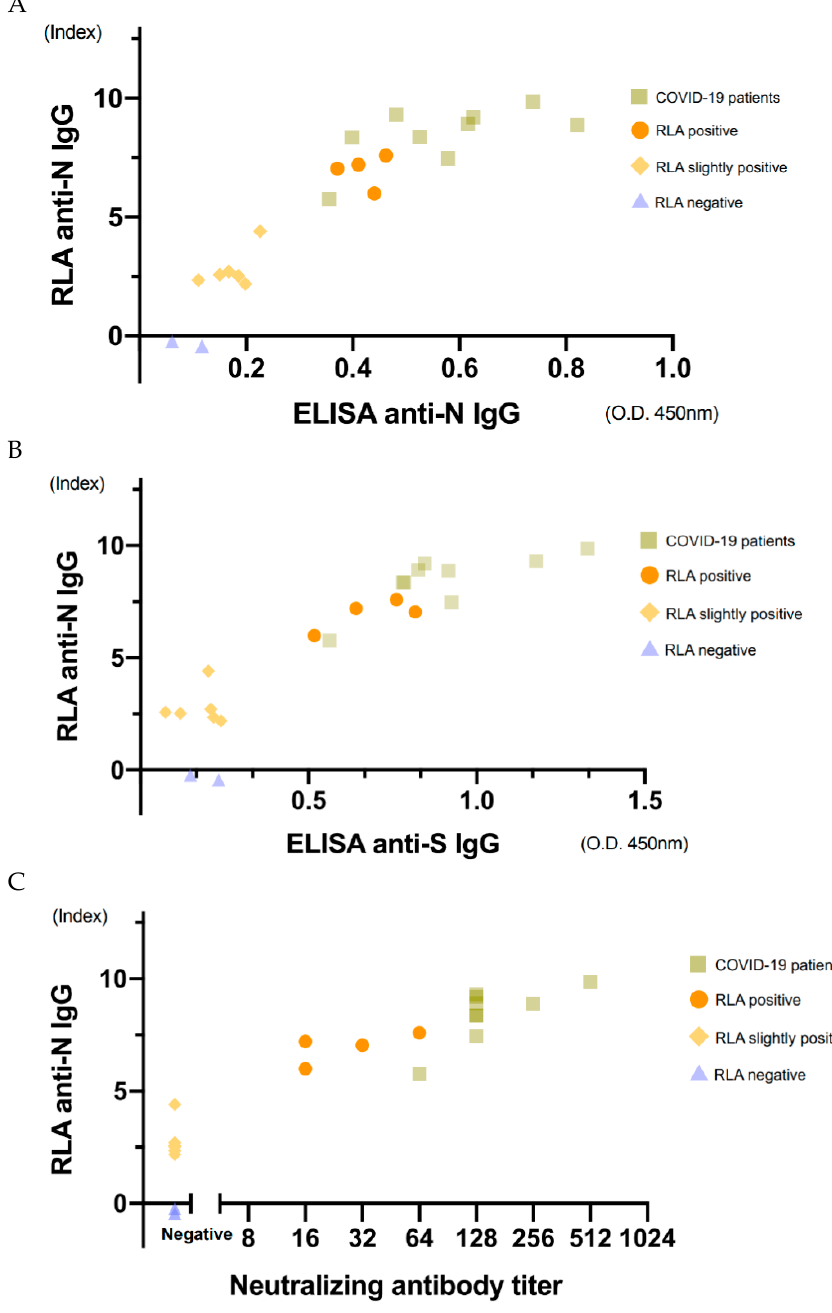
Figure 5. Correlation of the results obtained using RLA with those obtained using ELISA and neutralization titers. The 21 selected samples consisted of nine samples from patients with COVID- 19 and four apparently positive, six slightly high, and two negative samples from hospital staff. Correlation of the results obtained using RLA with anti-SARS-CoV-2 N determined using ELISA ( A ), anti-SARS-CoV-2 S determined using ELISA ( B ), and neutralization antibody titers ( C ). The correlation coefficients were 0.92, 0.87, 0.93 (Spearman’s rank correlation coefficient),